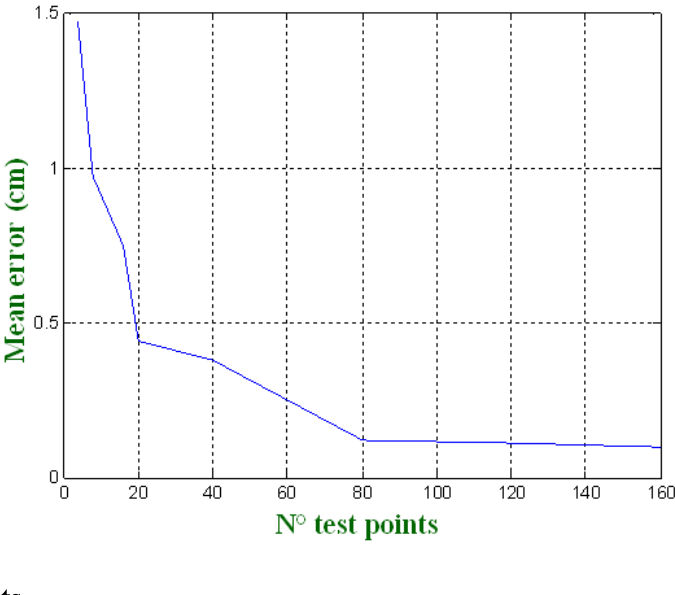
Figure 7. Average error in the beacon localization depending on the number of test points.